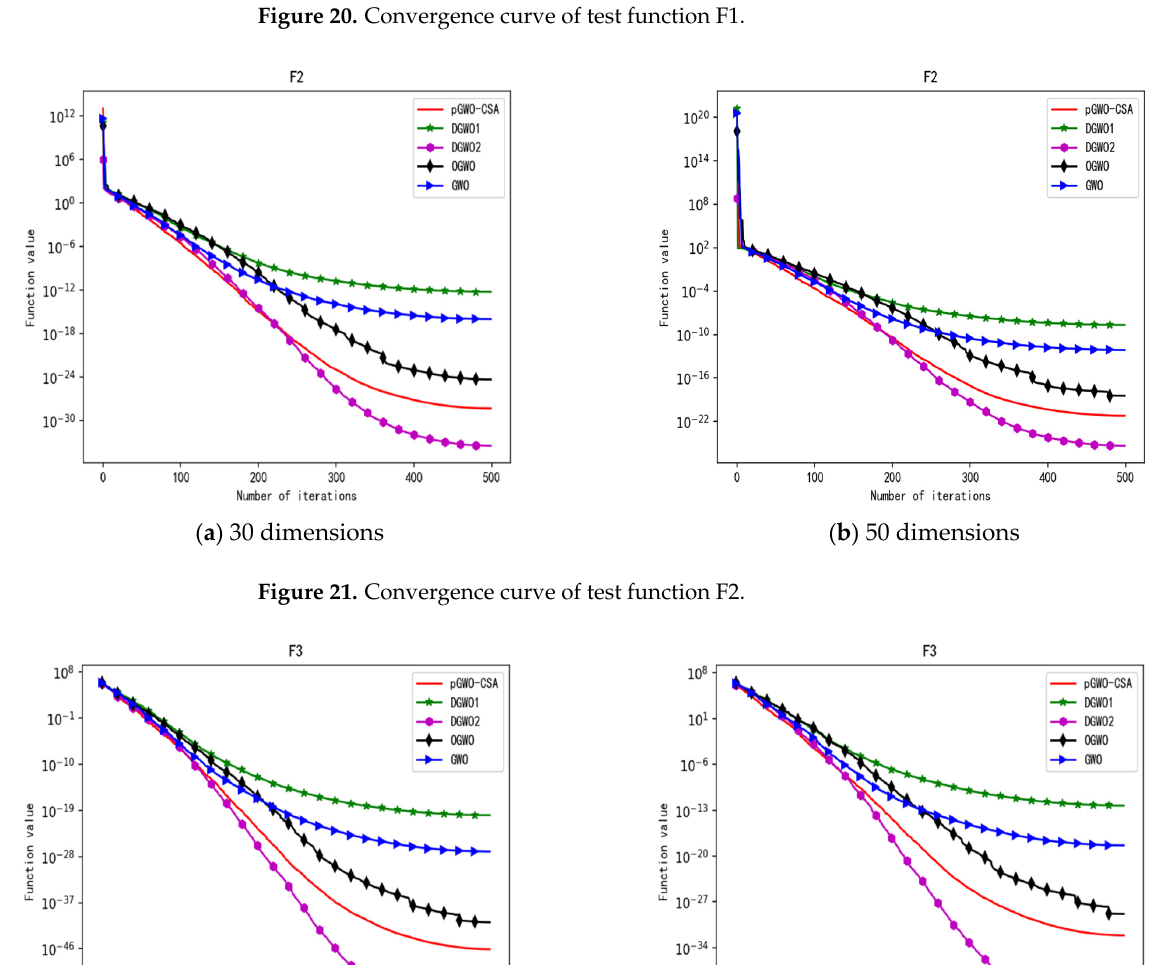
( b ) 50 dimensions Figure 23. Convergence curve of test function F4. ( a ) 30 dimensions